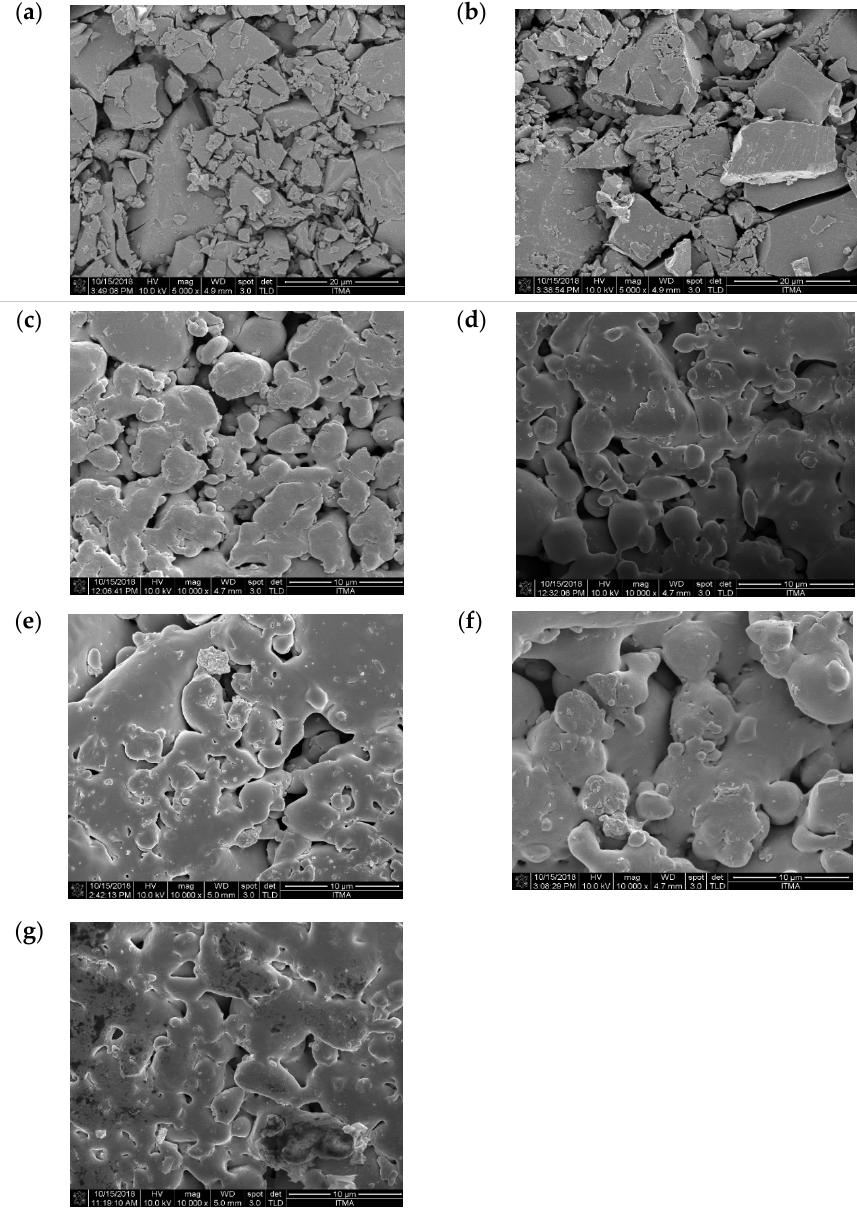
Figure 3. The surface morphology of the zinc silicate glass and glass-ceramics that were heat treated at various sintering temperature: ( a ) 27 ◦ C, ( b ) 700 ◦ C, ( c ) 750 ◦ C, ( d ) 800 ◦ C, ( e ) 850 ◦ C, ( f ) 900 ◦ C, and ( g ) 950 ◦